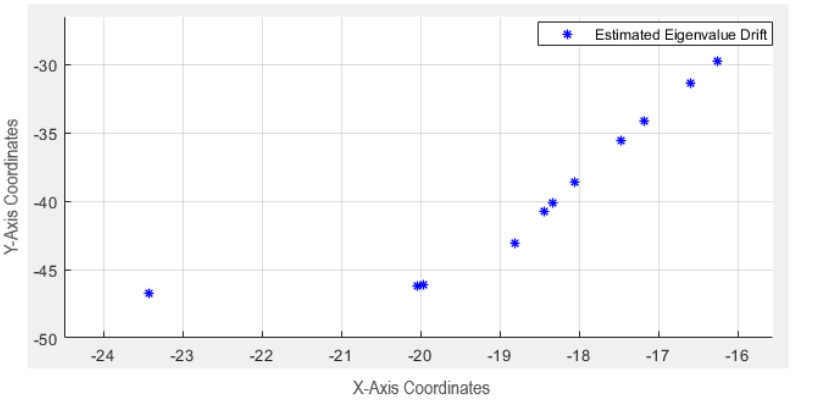
Figure 5. Estimated eigenvalues in eigenvalue space.